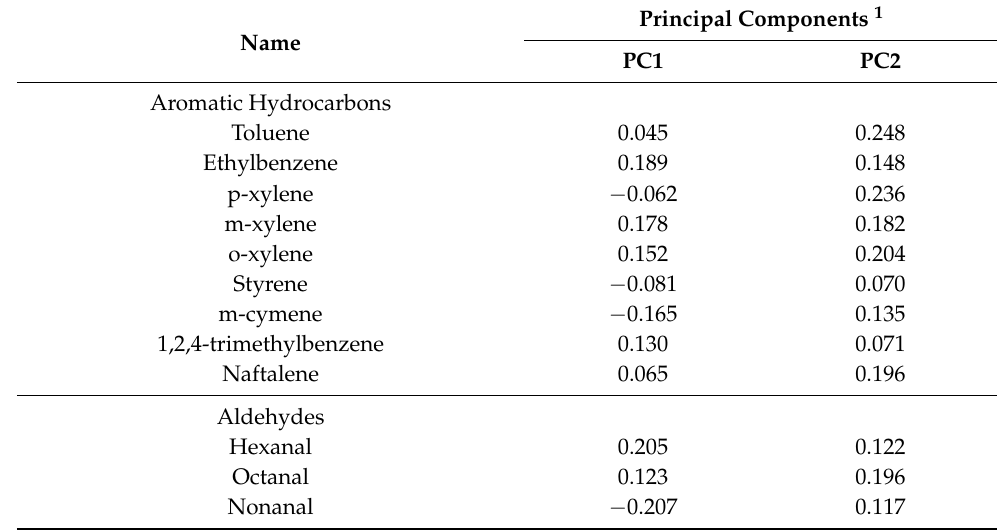
Table 2. Percentage variance and loading accounted by the first two principal components (PC1 and PC2) of tiger nut beverages’ volatile